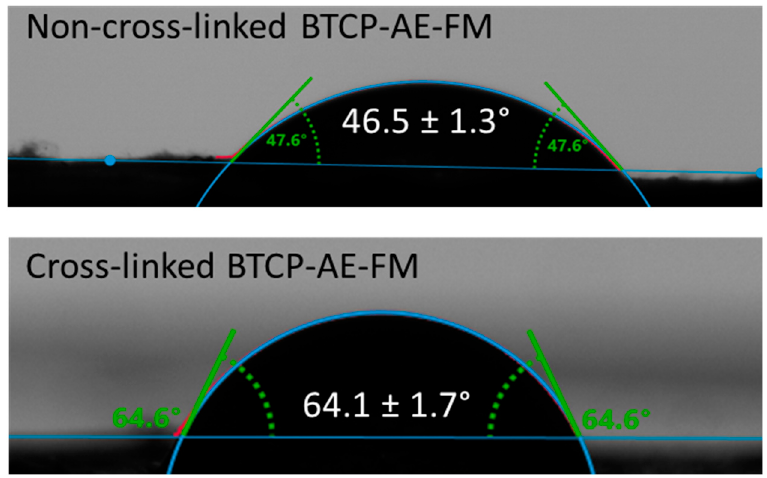
Figure 4. Water contact angles of the BTCP-AE-FMs before and after cross-linking.